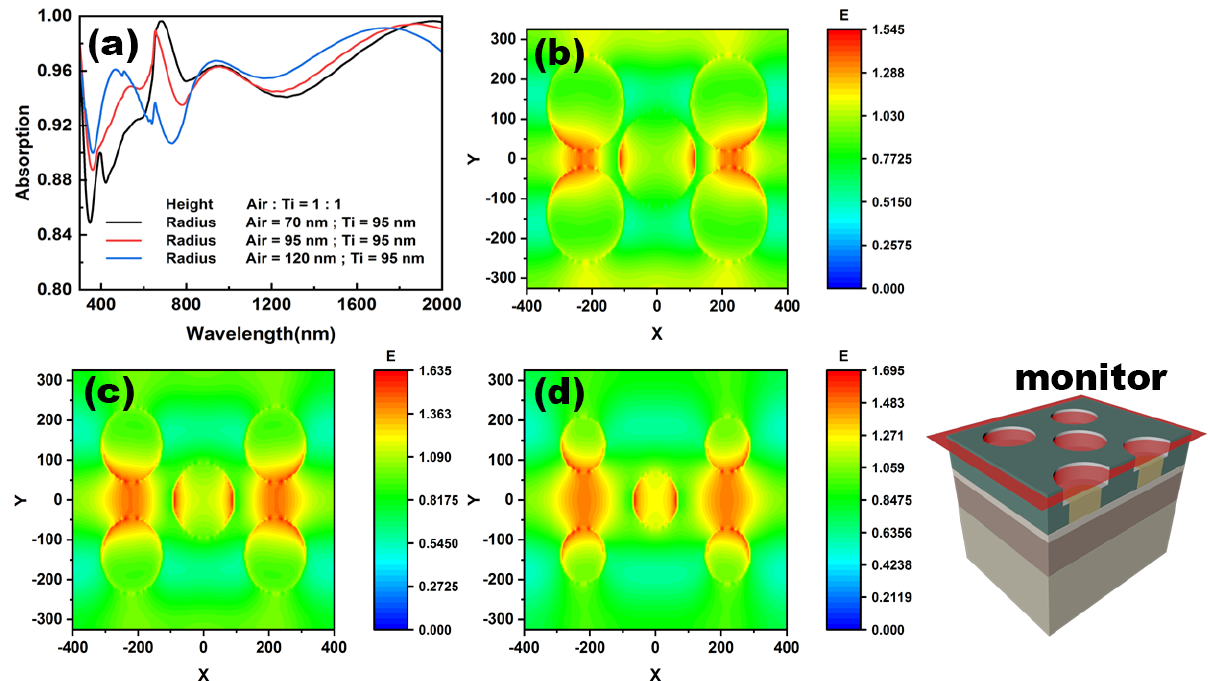
Figure 5. The absorptive spectra ( a ) and electric field distributions ( b − d ) in the same horizontal cross-section of the absorbers with different radii of air nanopillar, 120 nm ( b ), 95 nm ( c ), 70 nm ( d ). The height ratio of air to Ti nanopillar keeps 1:1.